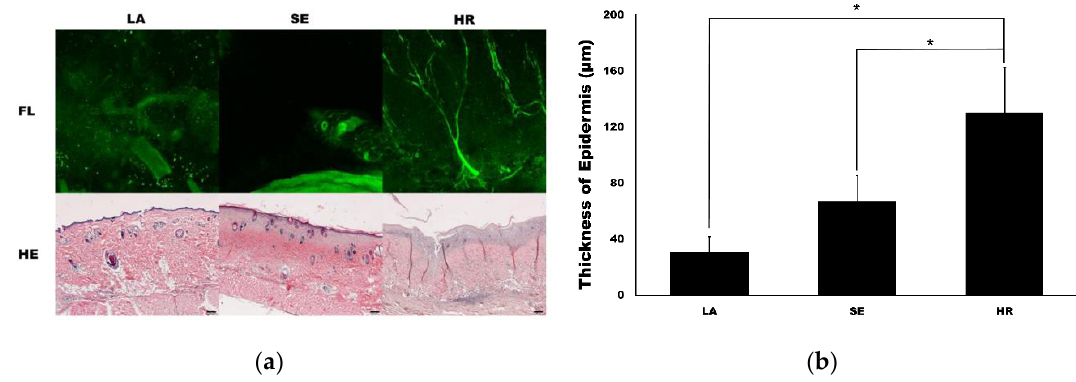
Figure 4. Capillary and epidermis regeneration. ( a ) The images from confocal microscopy (FL) and light microscopy (hematoxylin and eosin (HE)). Movie clips for confocal images are available in supplementary data. The regeneration of the capillary was prominent in the 4HR-administered group (HR) compared to the ointment base only group (LA) and sericin-administered group (SE) in confocal images (original magnification × 100). Epithelial regeneration shown in light microscopic views was also di ff erent among groups (original magnification × 40, hematoxylin and eosin stain). ( b ) The thickness of the epidermis was significantly di ff erent among groups ( p < 0.001). The thickness of the epidermis was significantly higher in the HR group than those in the LA and SE groups (* p <